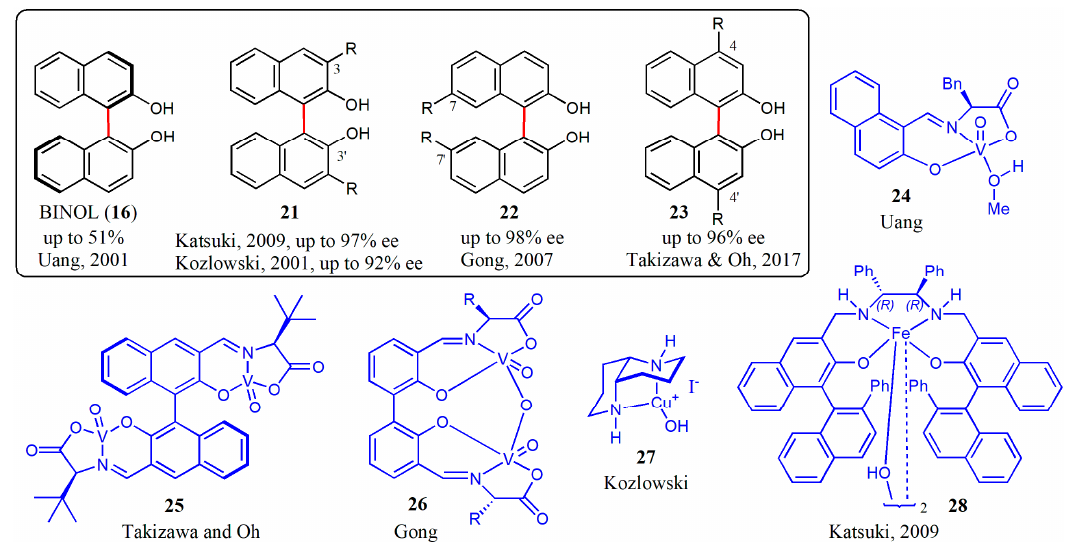
Figure 9. Optically stable BINOLs 16 and 21–23 .